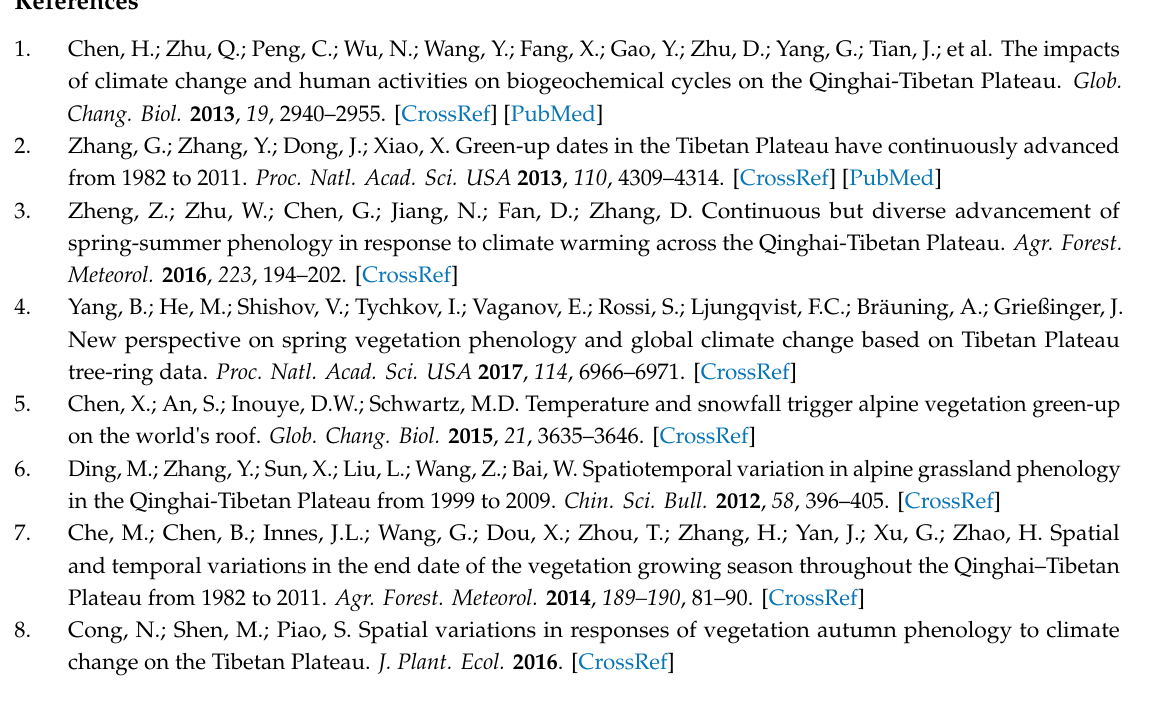
Table S1: Geographical coordinates and elevation of phenological stations and observed plant species at each station; Figure S1: MAE (a) / (d), RMSE (b) / (e) and correlation coe ffi cient (c) / (f) between multi-species mean brown-o ff date and NDVI / EVI2 retrieved median middle senescence date within di ff erent window size from 2000 to 2012; Figure S2: Frequency of stations with positive or negative regression coe ffi cients between (a) precipitation (PRE) / (b) daily minimum temperature (T min ) / (c) daily sunshine duration (SSD) / (d) daily mean relative humidity (H mean ) and the middle senescence date; Figure S3: Spatial patterns of stations with di ff erent climatic variables selected by the stepwise linear regression models for EVI2 retrieved MSD on the QTP. All legends are the same as in Figure 5; Figure S4: Number of climatic factors selected by the stepwise linear regression model in each meteorological station. (a) NDVI retrieved MSD, (b) EVI2 retrieved